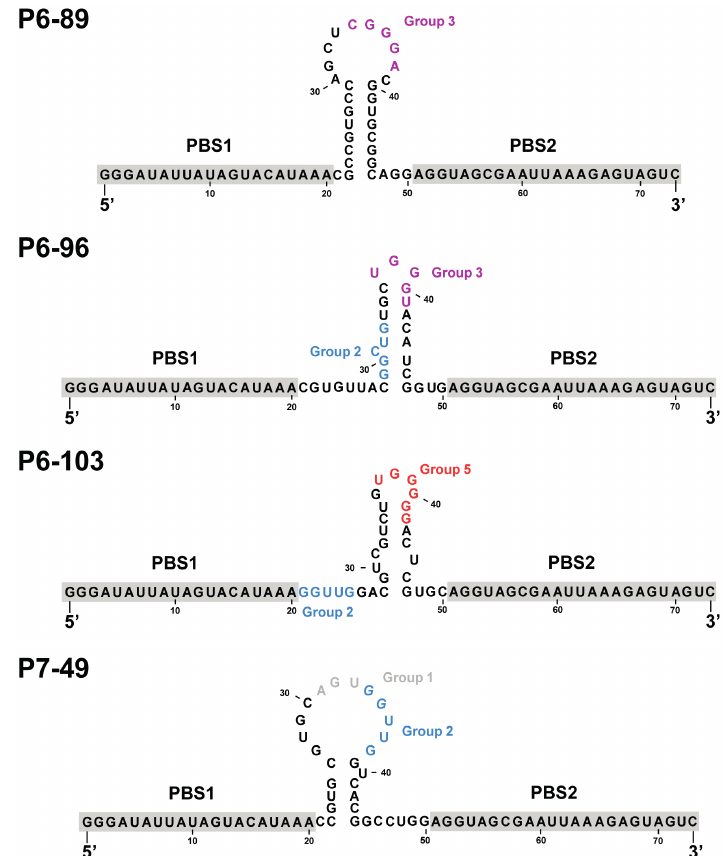
Figure 3. Proposed secondary structure of P6-86, P6-96, P6-103 and P7-49 as determined by TurboFold software. Theoretical nucleotide motifs involved in the interaction with the CRE are colored according to the group they belong to, as indicated in Figure 1B. The constant and common sequences for all the aptamers tested, PBS1 and PBS2, are highlighted in grey. PBS, primer binding site.